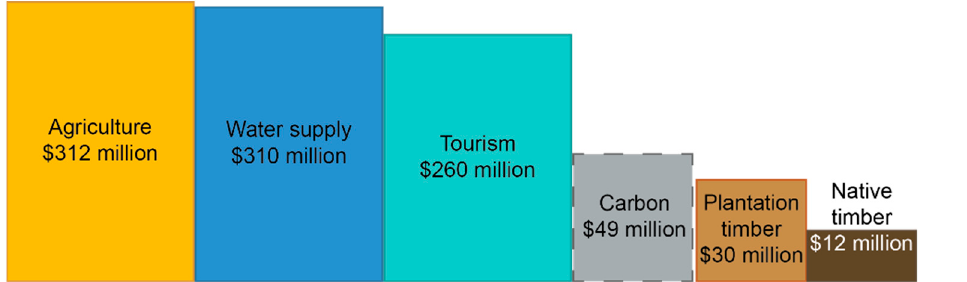
Figure 3. Outcomes of ecosystem accounting for the key natural asset-based industries in the Central Highlands of Victoria. (Drawn from data and analyses in Keith, Vardon, Stein, Stein and Lindenmayer [29]).